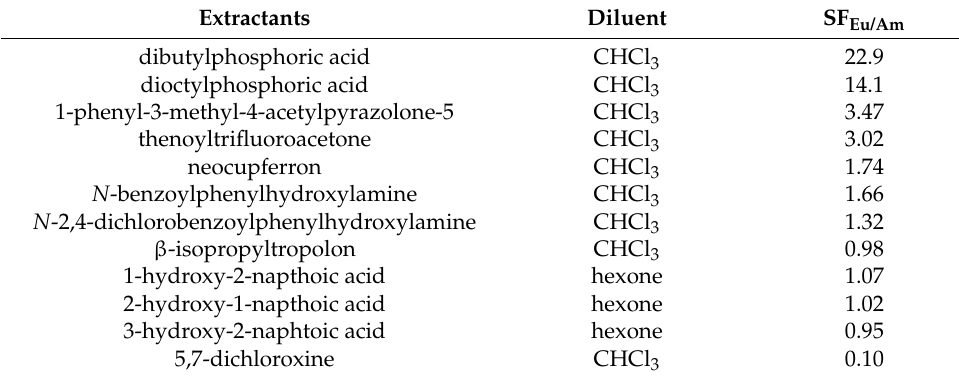
Table 1. Europium/americium separation factors for a series of acidic extractants. Adapted with permission form Ref. [30].